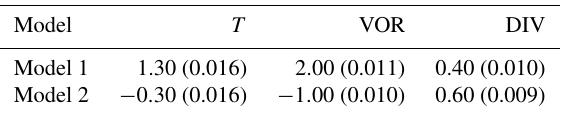
Table 5. Weights for the supermodel trained by the synch rule. Be- tween brackets the standard deviation over the last 10 weeks of training is given.